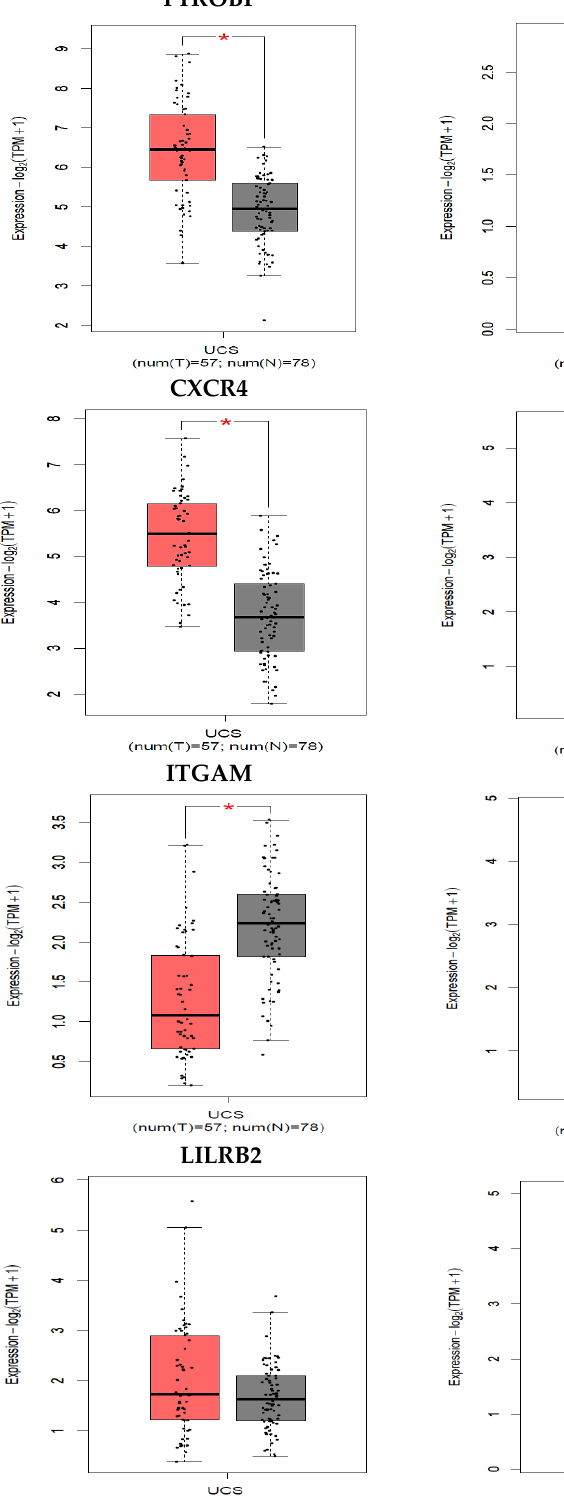
Figure 8. Kaplan–Meier overall survival analysis of the hub genes expressed in CC. Curves were generated using Gene Expression Profiling Interactive Analysis based on The Cancer Genome Atlas database ( p ≤ 0.01).